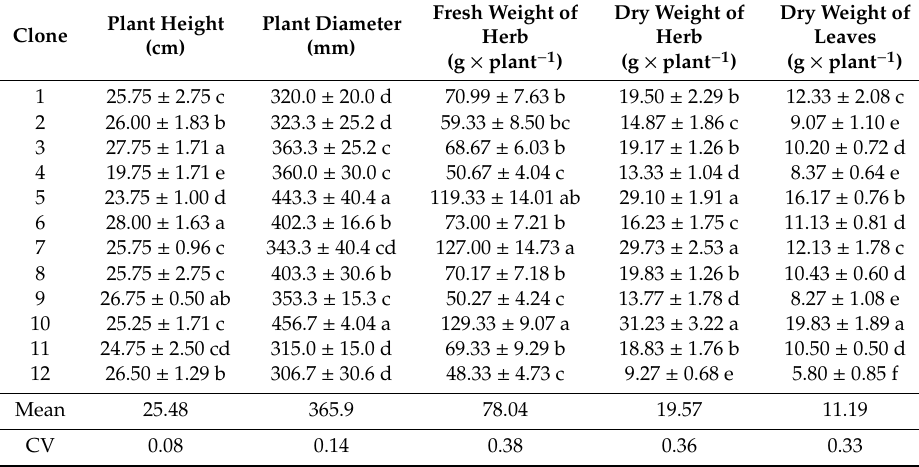
Means marked with di ff erent letters di ff er at p < 0.05